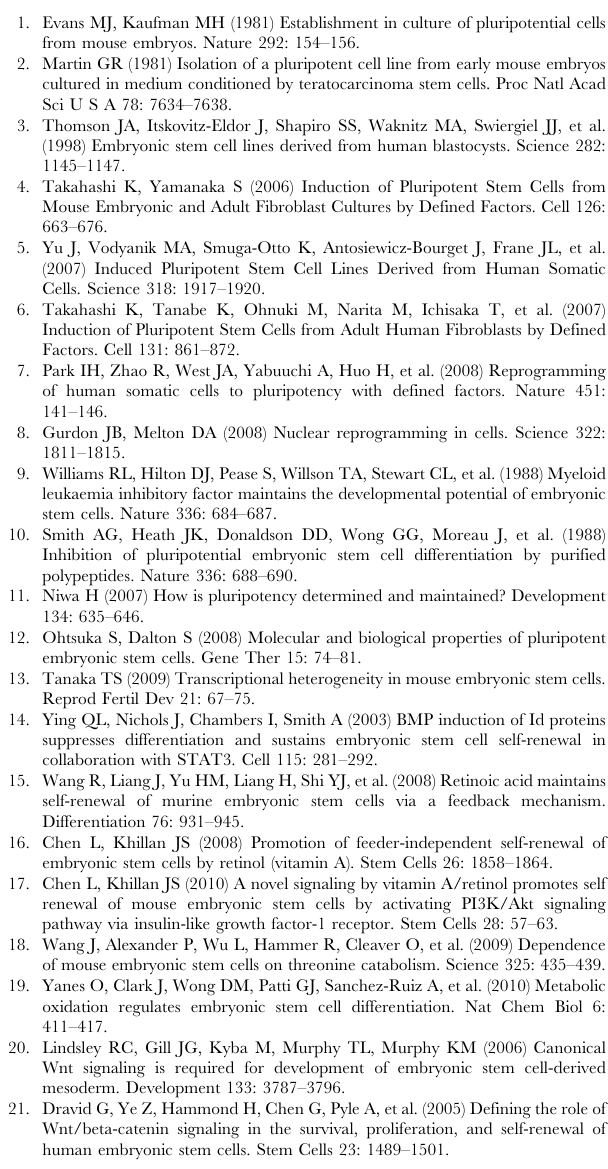
Table S1 Effects of serum on the tumorigenicity of mouse embryonic stem